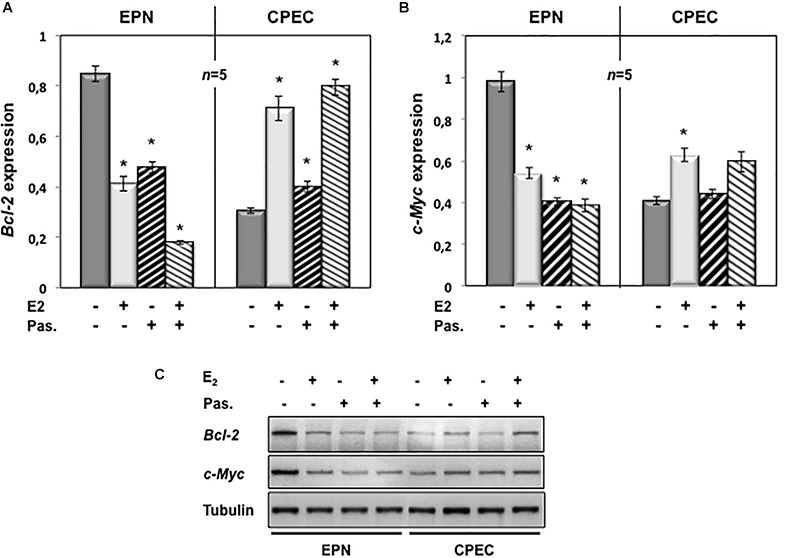
Effect of both estradiol and pasireotide on Bcl-2 and Myc mRNA expression levels. EPN or CPEC cells were untreated or treated for 24 h with estradiol (20 nM; E2), in the absence or presence of 1 μM pasireotide. RT-PCR analysis of Bcl-2 (A) and c-Myc (B) mRNA levels was done. Densitometry analysis of agarose gel electrophoresis was done. The expression level is indicated as fold changes from basal conditions (A.U.). Histograms represent the averages (+/- standard error) from five independent experiments, normalized for the expression of the control housekeeping gene GAPDH. Means and SEMs are shown. n represents the number of experiments. ∗p < 0.05 for each experimental point versus the corresponding untreated control. In panel (C), EPN or CPEC cells were untreated or treated for 24 h with estradiol (20 nM; E2), in the absence or presence of 1 μM pasireotide. Lysate proteins were prepared, electrophoretically separated by SDS-PAGE and transferred to PDVF membrane. Filters were immune-blotted using anti-Bcl-2 or anti-c Myc or anti-tubulin antibodies.